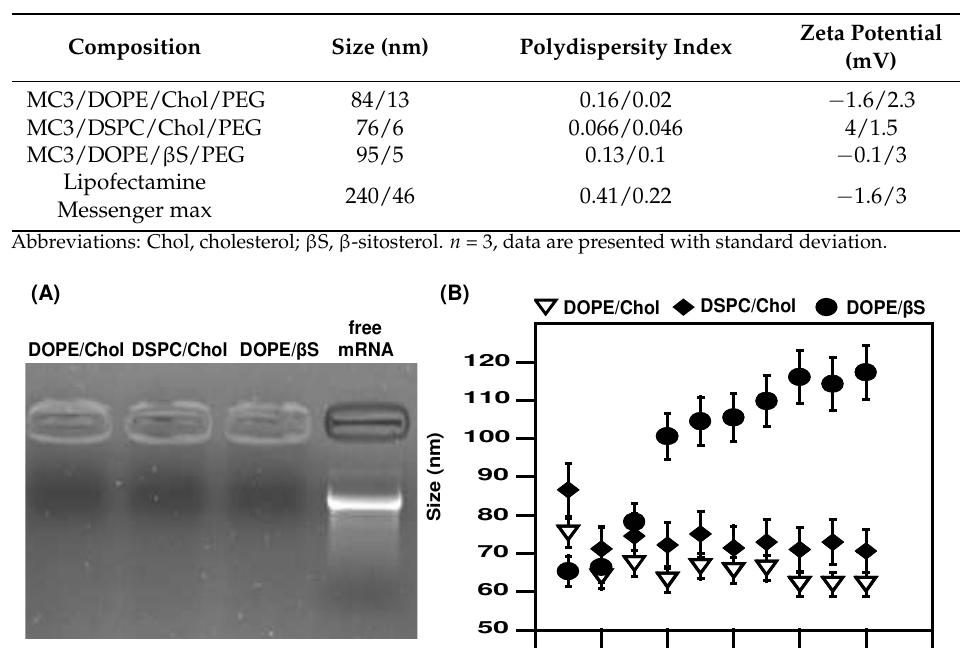
Table 1. Size and zeta potential of LNPs.